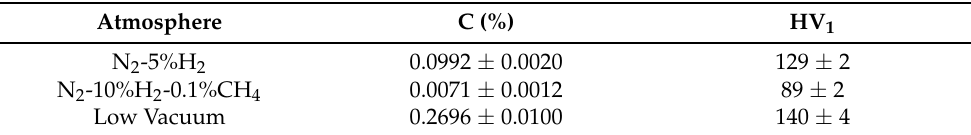
Table 4. Effect of the sintering atmosphere on the carbon content and